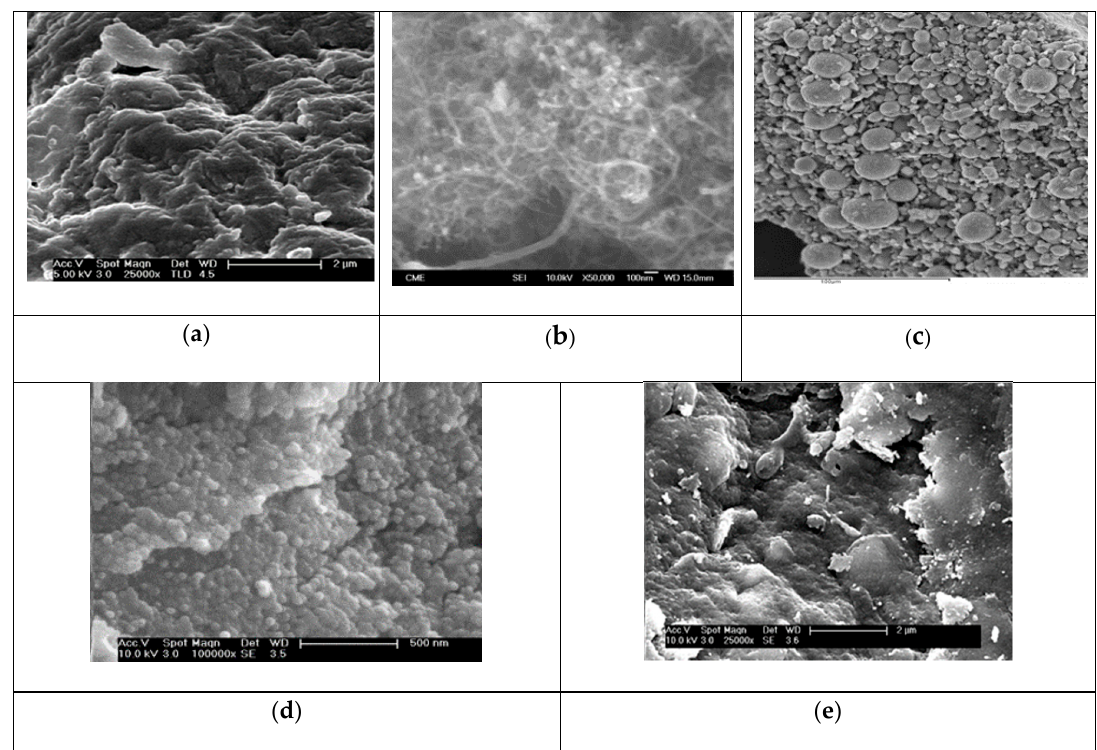
Figure 4. SEM micrographs of ( a ) alginate, ( b ) f-CNT, ( c ) γ -Fe 2 O 3 particles, ( d ) A/ γ -Fe 2 O 3 and ( e ) A/ γ -Fe 2 O 3 /f-CNT beads.